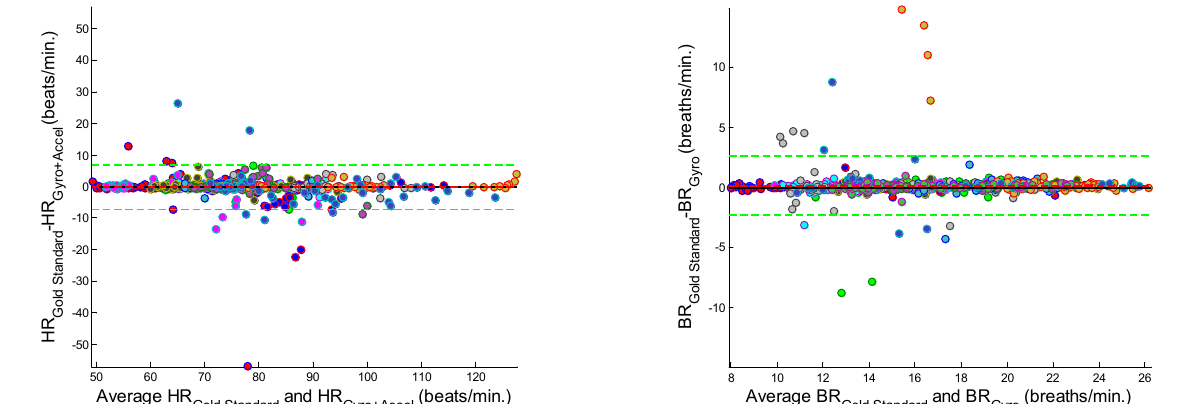
Fig. 5. Bland-Altman plots for heart (left) and breathing rates (right) using the best combination of motion sensors for each case. The graphs show the agreement of 594 pairs (left) and 648 pairs (right) of measurements. Data from different participants are represented with dots of different colors. Mean error is depicted with slashed red and 95% limits are depicted with slashed green lines. (HR: Heart Rate, BR: Breathing